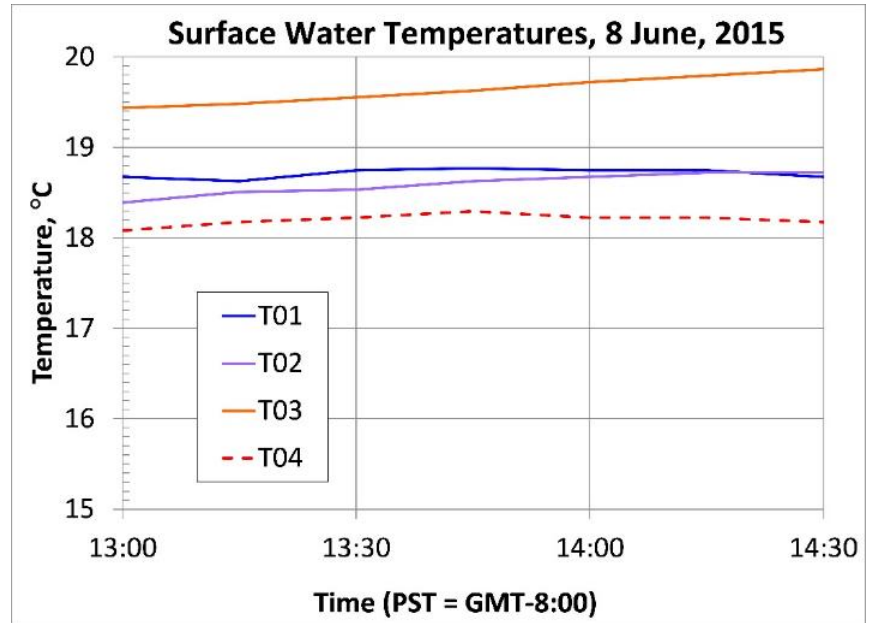
Figure 12. Surface water temperature longitudinal changes for temperature data loggers T01–T04 (see Figure 8 for locations).